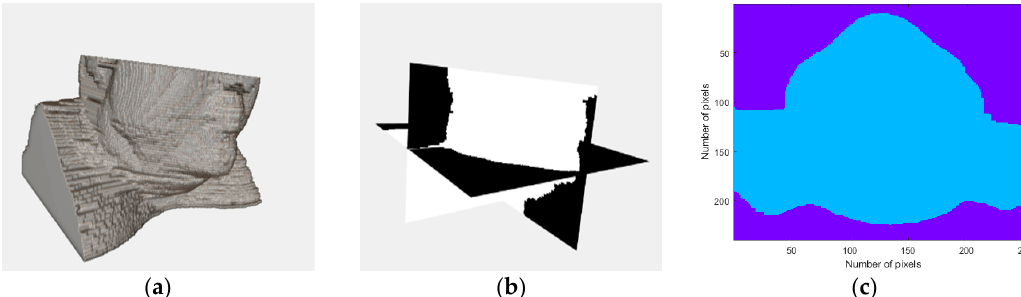
Figure 4. Visualizations of the simplest 3D head and neck phantom obtained from the developed phantom generator: a homogeneous phantom. ( a ) Realistic 3D rendering of the obtained phantom. ( b ) Scheme of the planes: coronal, sagittal and axial planes. ( c ) Corresponding axial plane of the generated phantom. Two regions are highlighted: the background (air) and the human body (homogenously modelled as fat tissue).